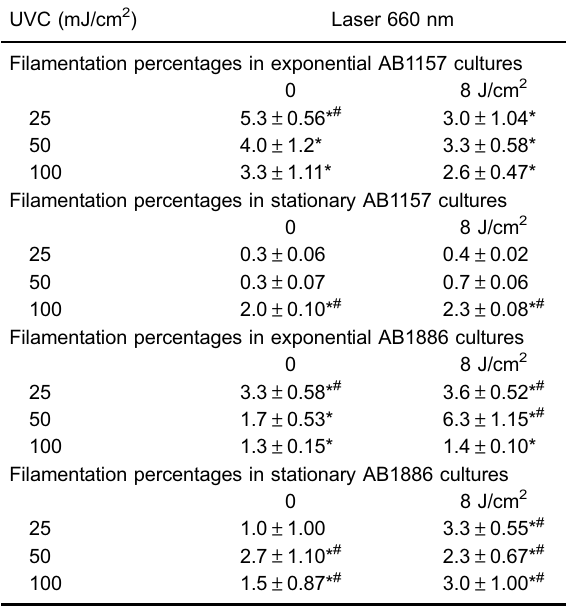
Table 3. Percentages of fi lamentation in E. coli cultures exposed to low-intensity red laser and ultraviolet C (UVC)